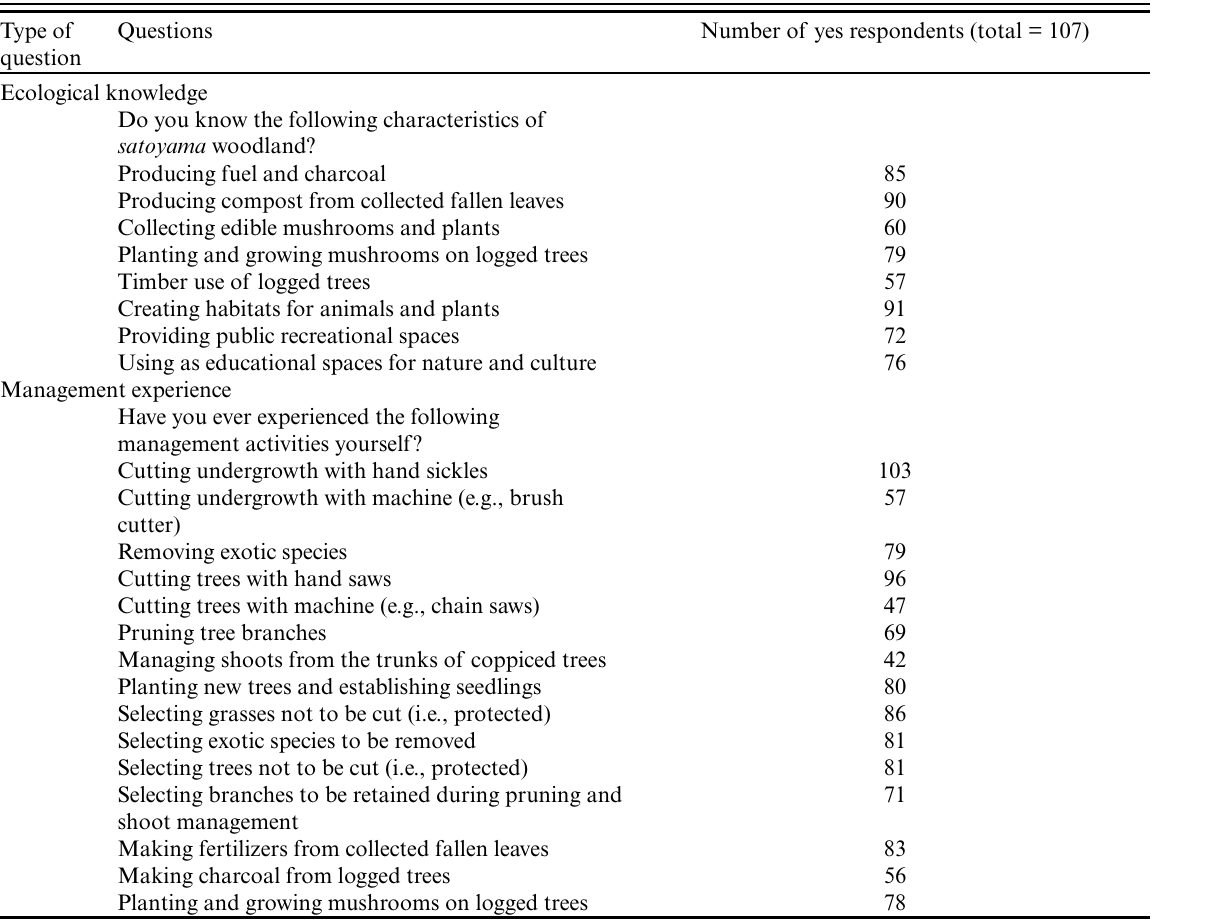
Table 3 . Questions to individuals on knowledge and experience in woodland